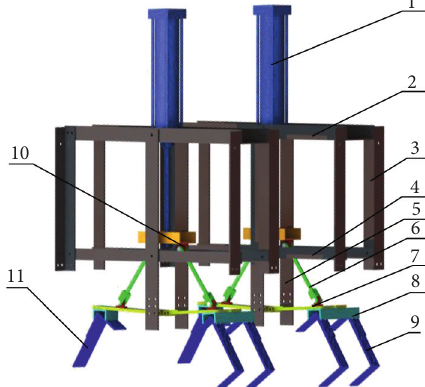
Figure 9: Manipulator structure.